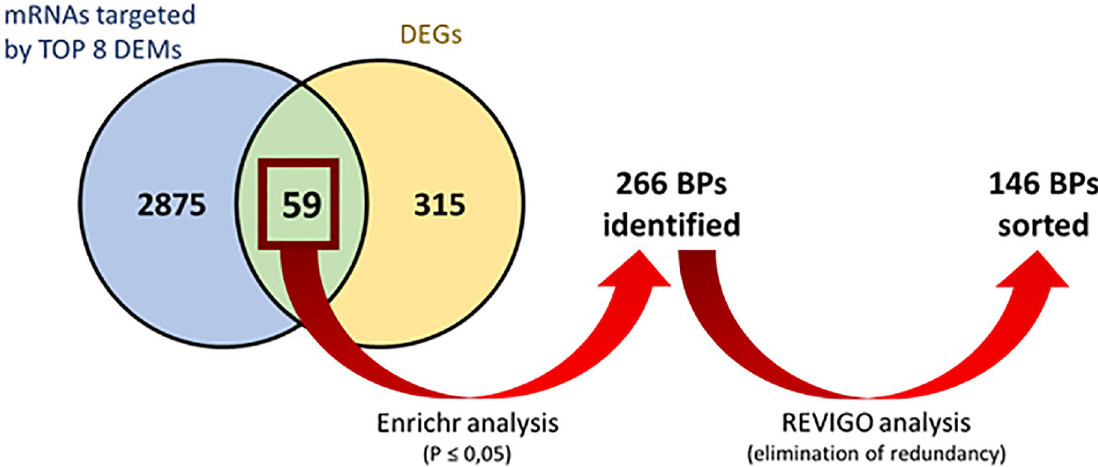
Fig 2. Comparison between mRNA targeted by the 8 most expressed DEMs and DEGs in Holstein cows. Venn diagram between the potential targets of DEMs (blue circle) and the 374 DEGs (yellow circle). Red arrows indicate the workflow used to analyze biological processes (BPs) common mRNA with the Enrichr and REVIGO platforms.